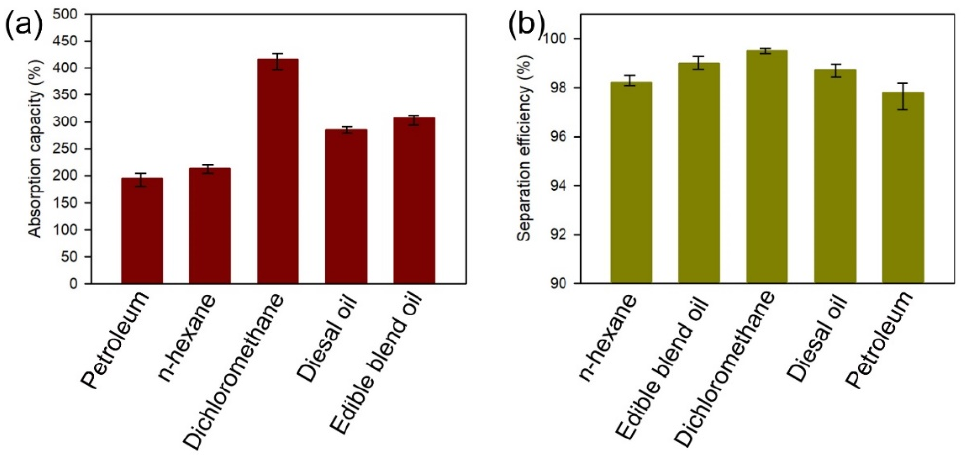
Figure 7. Absorption capacities ( a ) and oil–water separation efficiencies ( b ) of the superhydrophobic cuttlebone for various oil and organic solvents.